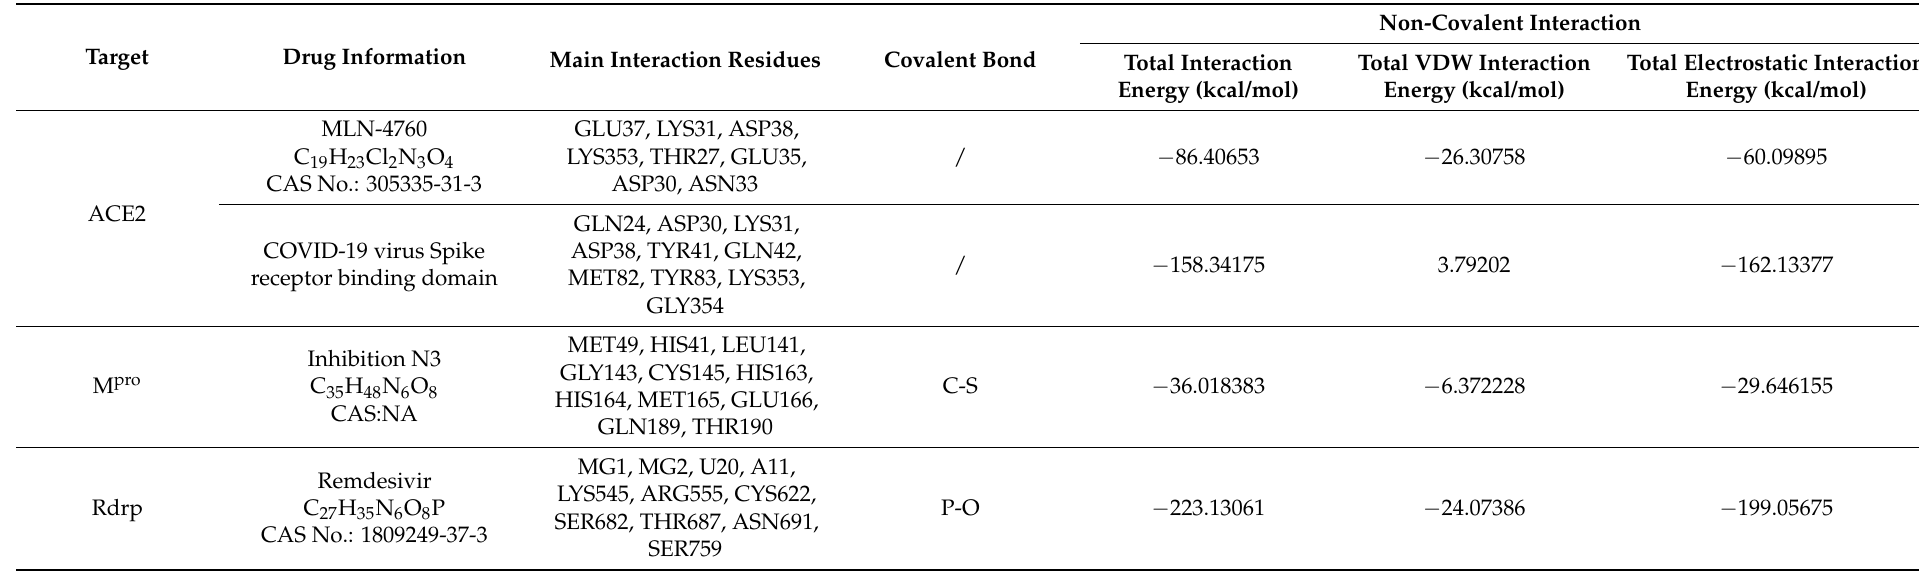
Table 2. Docking results and binding sites for the reported drugs and ligand residues inhibiting the possible targets of COVID-19